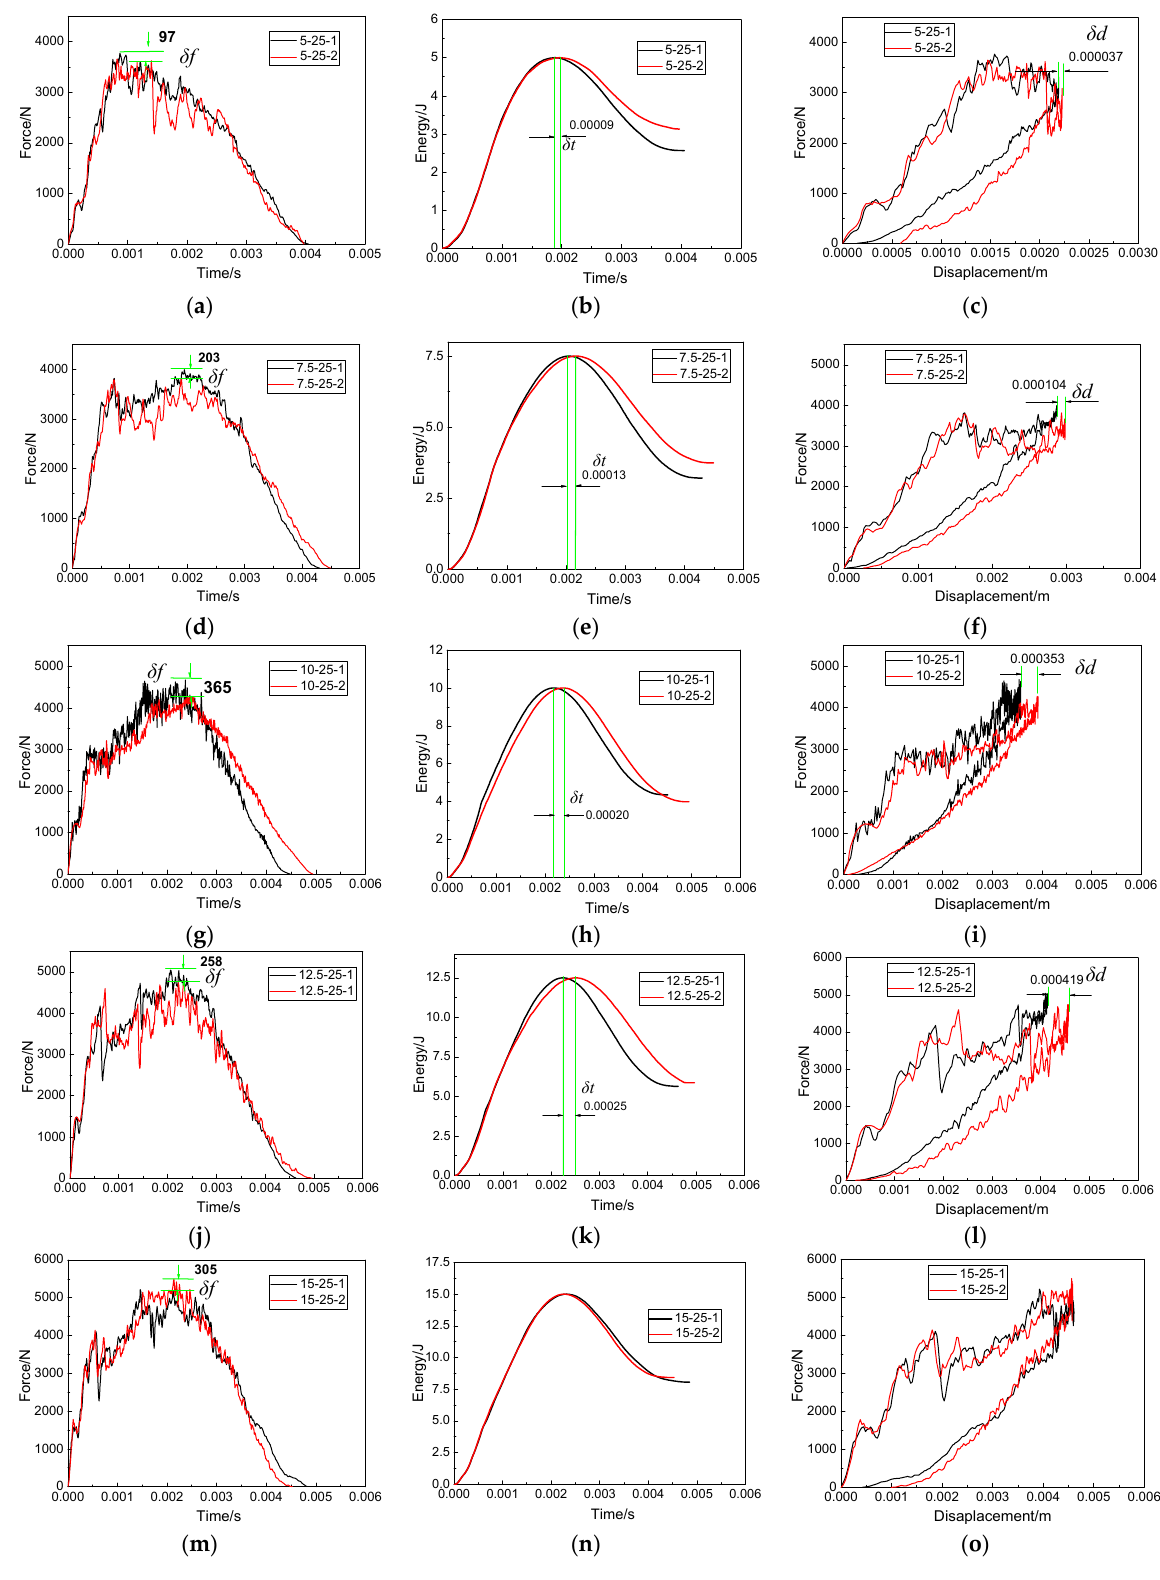
Figure 15. Force–time curves (a,d,g,j,m) , absorbed energy curves (b,e,h,k,n) and force–displacement curves (c,f,i,l,o) under double